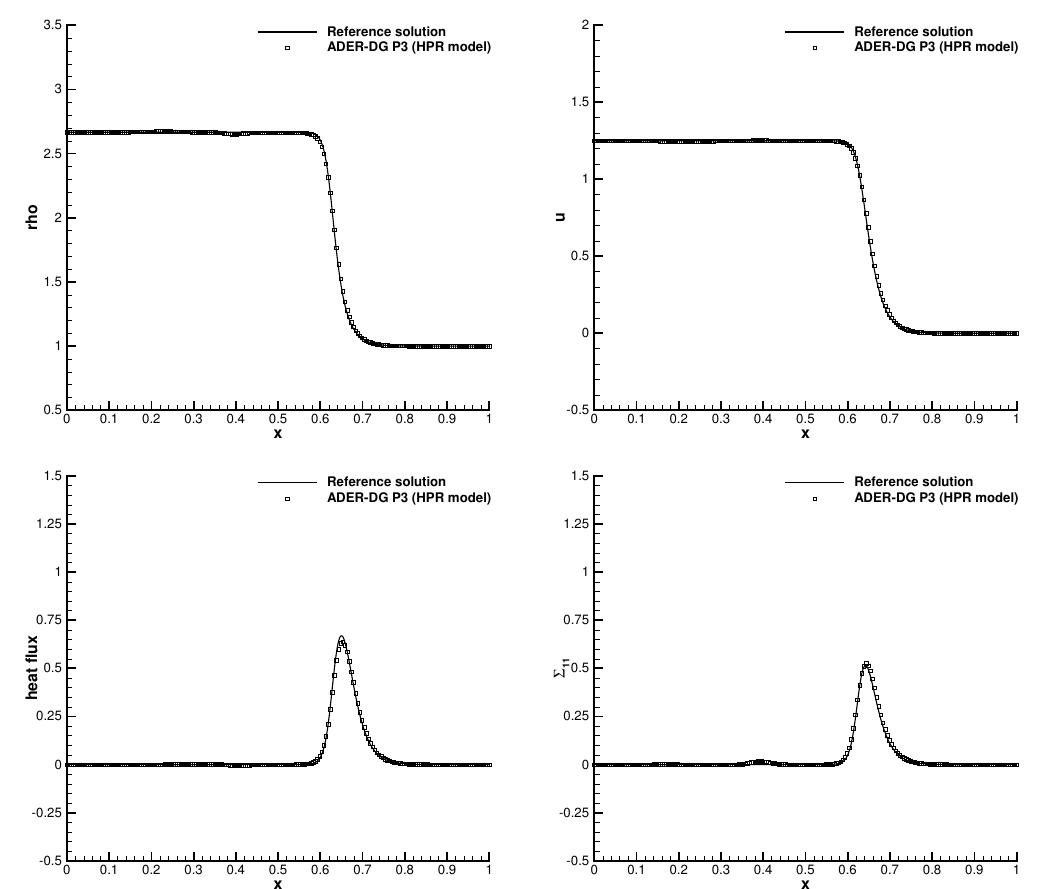
Figure 4. Viscous heat conducting shock. Comparison of the exact solution of the compressible Navier-Stokes equations with the numerical solution of the GPR model based on ADER-DG P 3 schemes. Density profile ( top left ), velocity profile ( top right ), heat flux ( bottom left ) and stress σ 11 ( bottom right